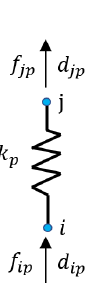
Figure 5. Forces and displacements of a massless spring connecting nodes i and j